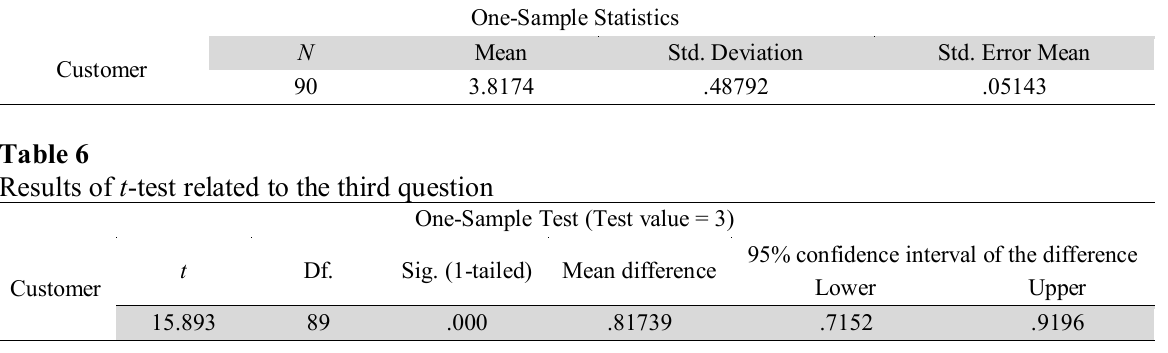
Results of descriptive statistics related to the customer aspect